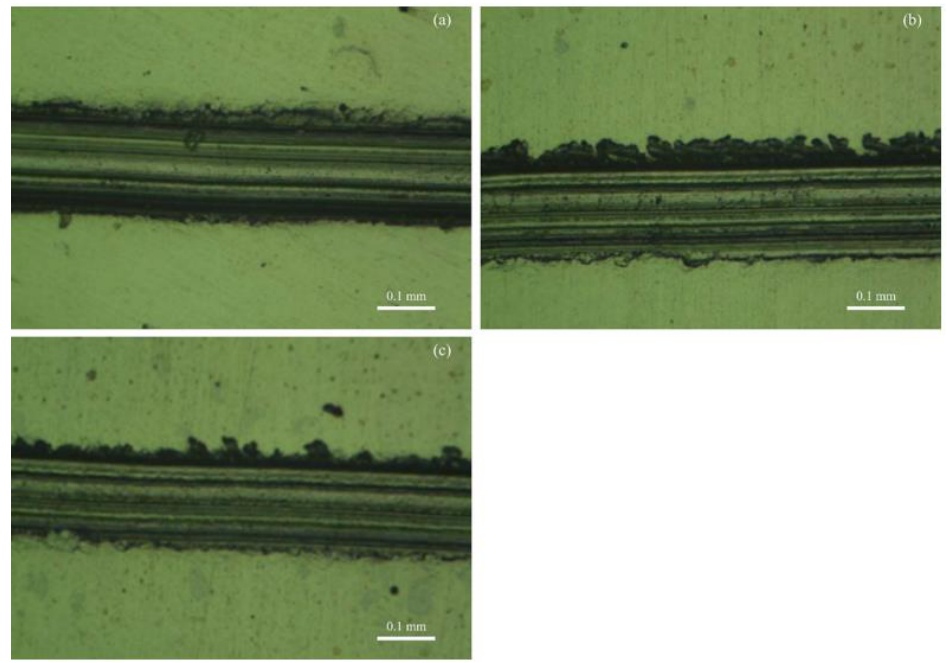
Figure 6. The microscratch structure of various coatings of B 4 C/Ni63 ( a ) 10% B 4 C, ( b ) 20% B 4 C, ( c ) 30% B 4 C.